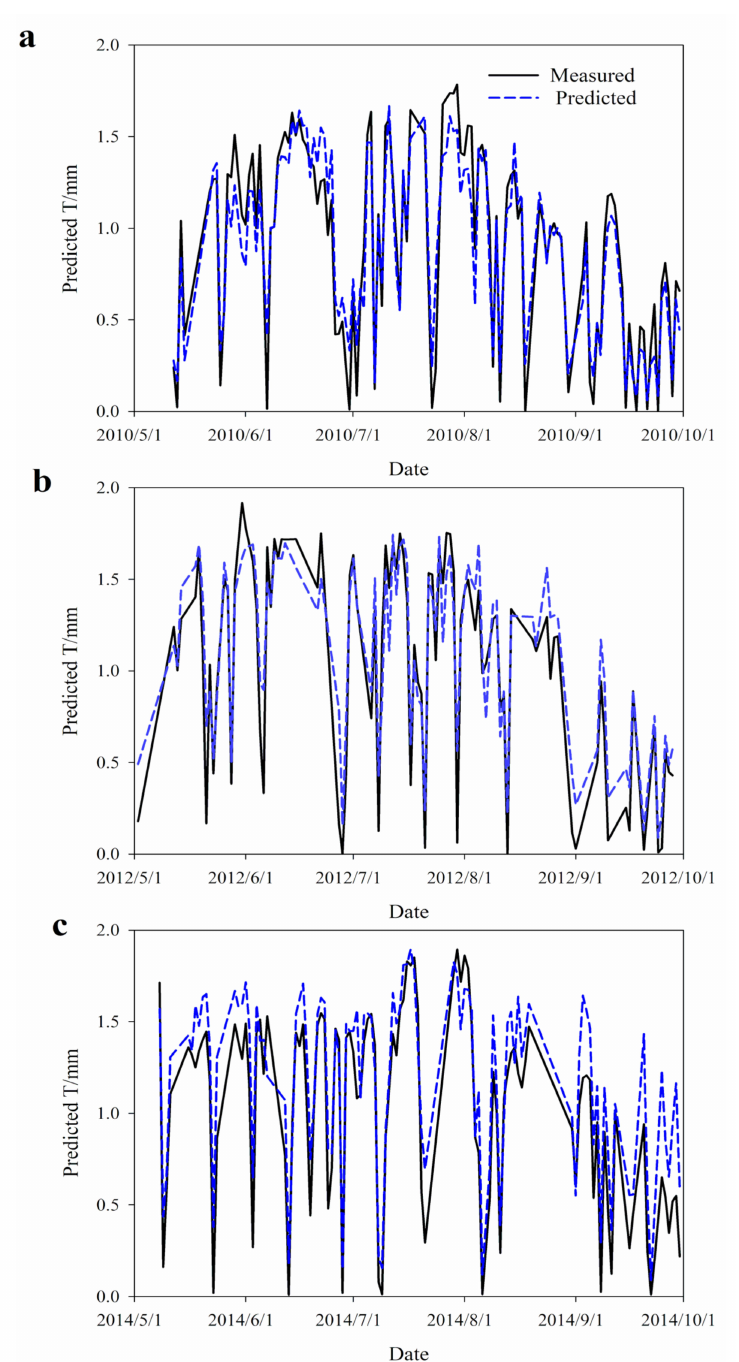
Figure 6. Comparison between the model predicted (dotted blue line) and measured T (solid black line) of the larch plantation in the growing seasons of 2010 ( a ), 2012 ( b ), and 2014 ( c